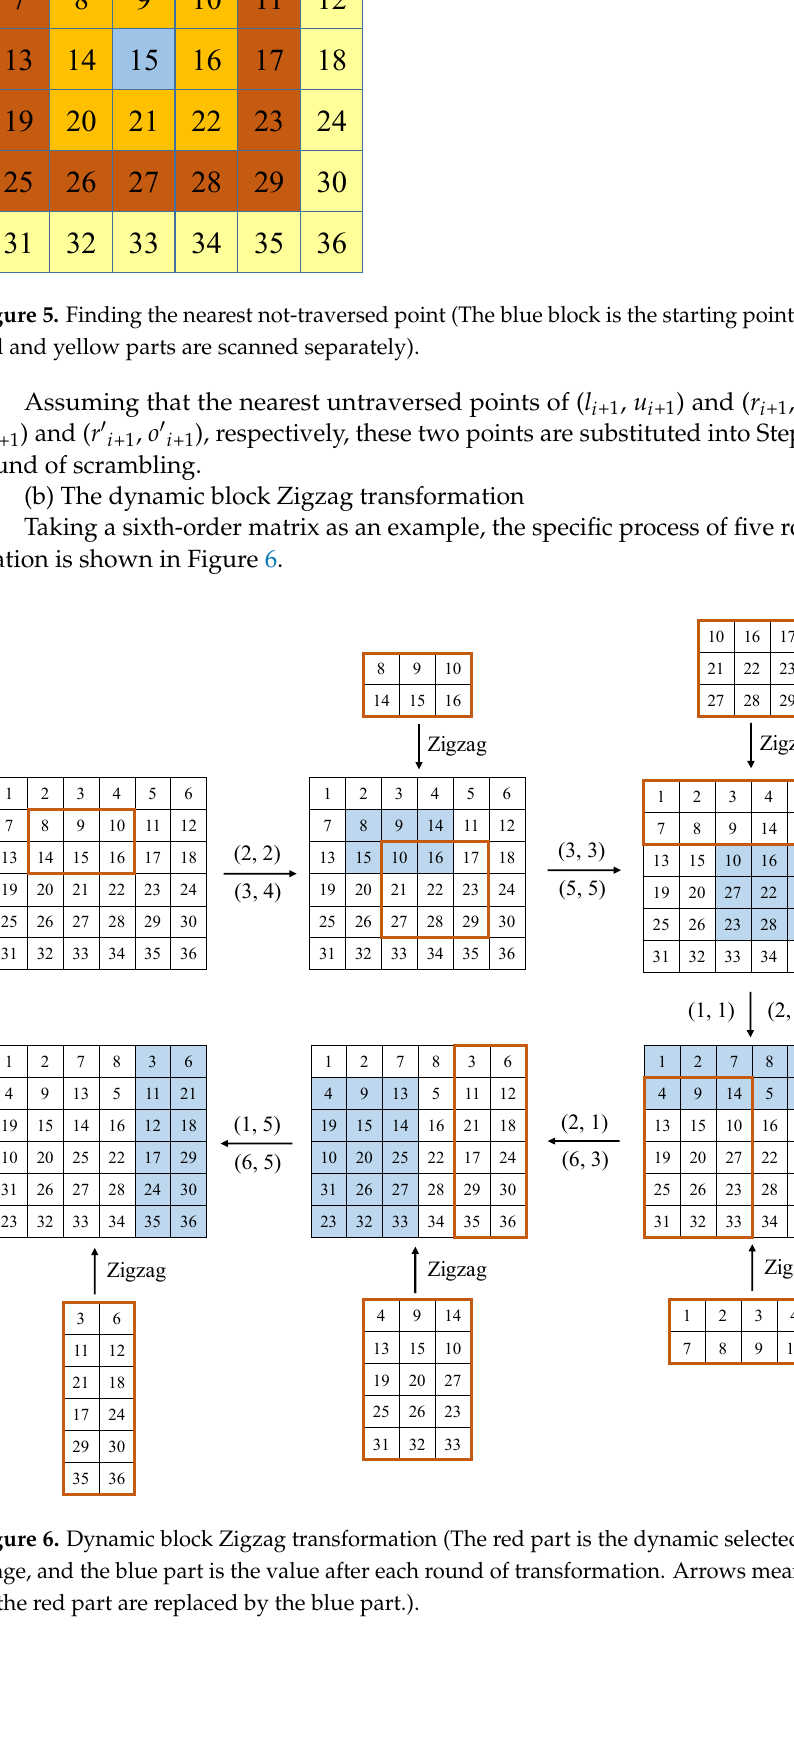
7 of 33 Algorithm 1: Image scrambling Input: